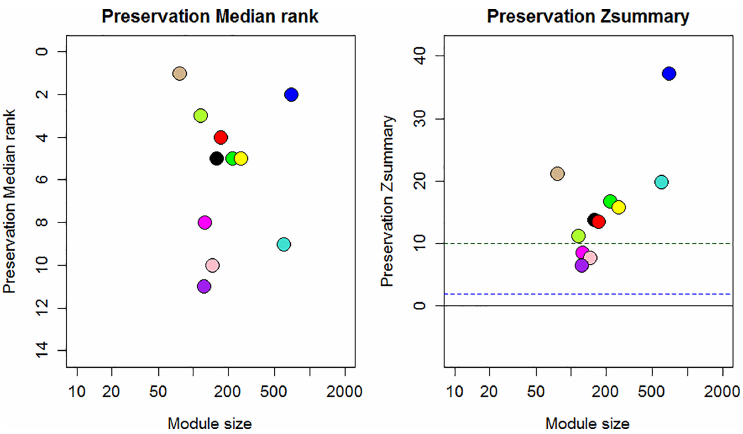
Fig 5. The medianRank and Zsummary statistics of module preservation of cold modules in drought modules (y- axis) vs. module size (x-axis). In plot colored circles represents gene modules of cold common gene co-expression network. The black borderline represents no preservation (Z-score = 0), blue borderline represents very weak preservation limits (Z-score = 2). The region between blue borderline and green borderline represents weak to moderate preservation zone (10 < Z-score > 2) and above green borderline represent strong preservation (Z-score > 10).